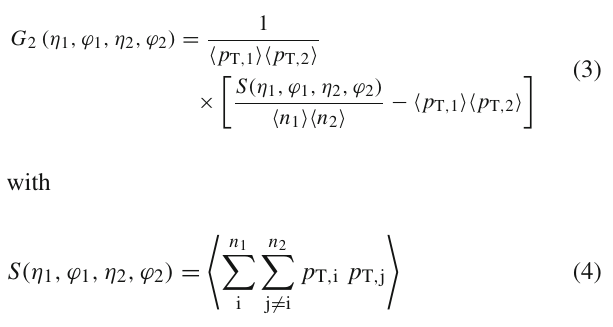
along (cid:8)η [17]. These values are plotted as a function of the number of collision participants estimated from Glauber models [42] in Fig. 2.